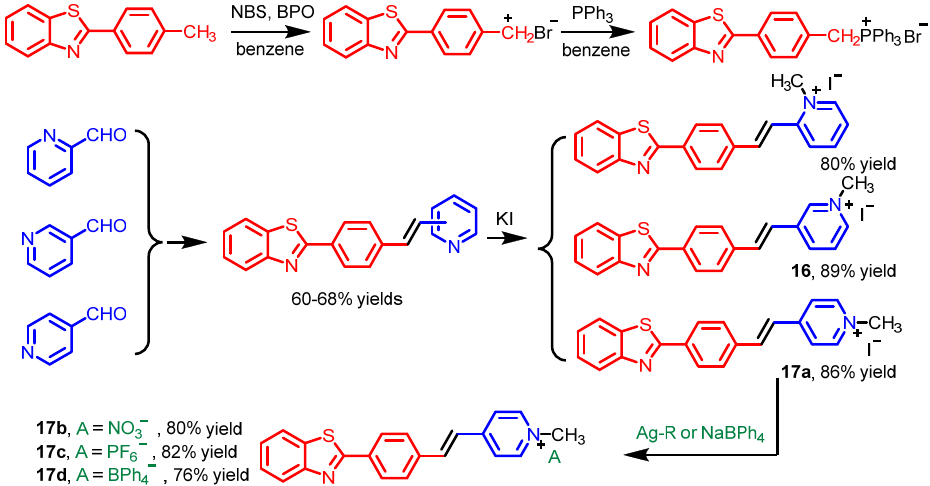
Scheme 13. Synthesis of compounds 16 and 17a – d .